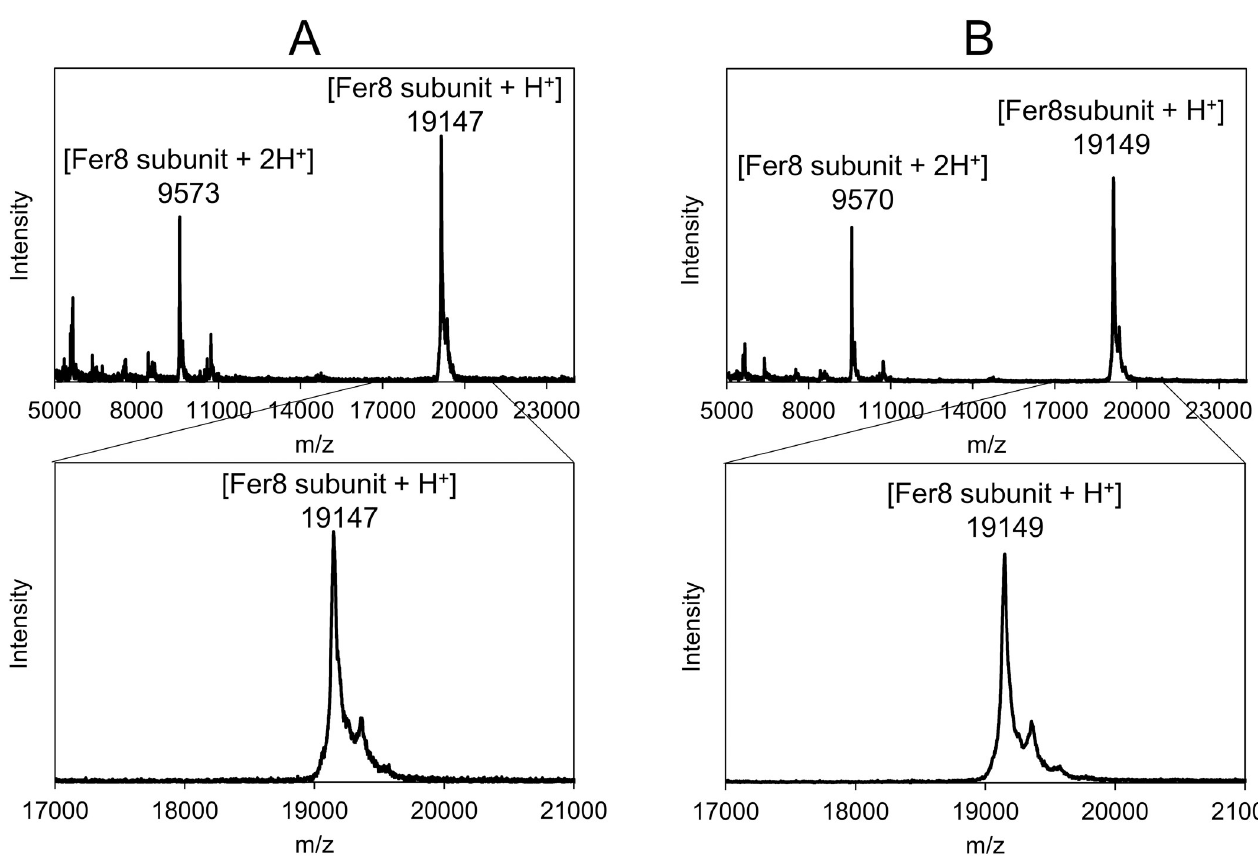
Fig 2. MALDI-TOF MS spectra of apoferritin hydrogel. (A) MALDI-TOF MS spectra of apoferritin hydrogel and (B) MALDI-TOF MS spectra of Fer8 solution after heating the apoferritin hydrogel at 90˚C for 30 min. Wide range (top) and expanded range (m/z 17,000–21,000) (bottom). Sinapinic acid was used as a